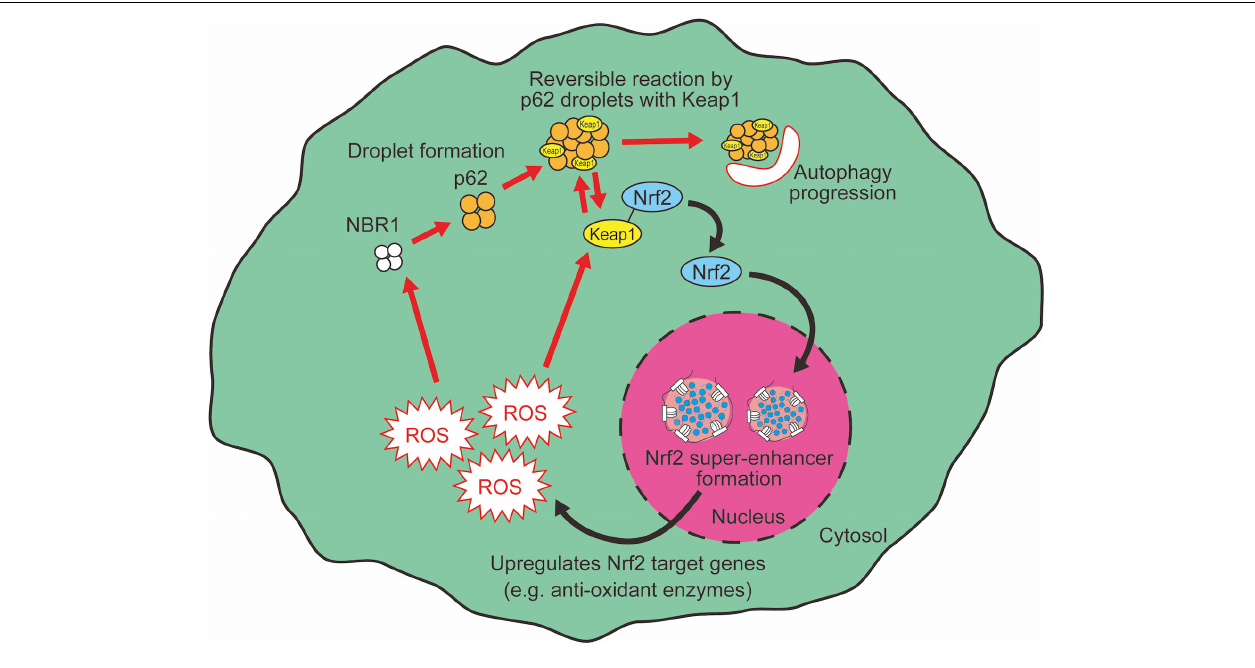
FIGURE 3 | LLPS mediates Nrf2